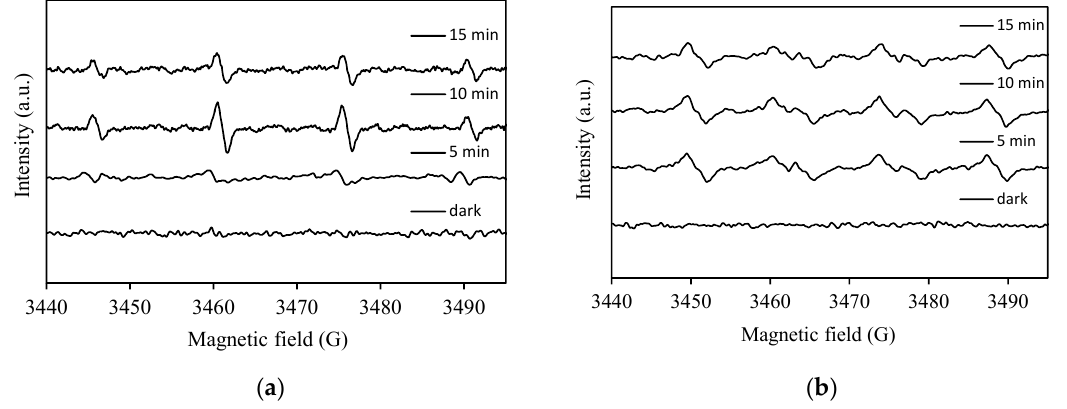
Figure 11. 5,5-dimethylpyridine- N -oxide (DMPO) spin-trapping ESR spectra for DMPO- • OH and DMPO- • O 2 − under visible-light irradiation with 1.0 wt% Pt / AgInS 2 photocatalyst. ( a ) DMPO- • OH ( b ) DMPO- • O 2 − .